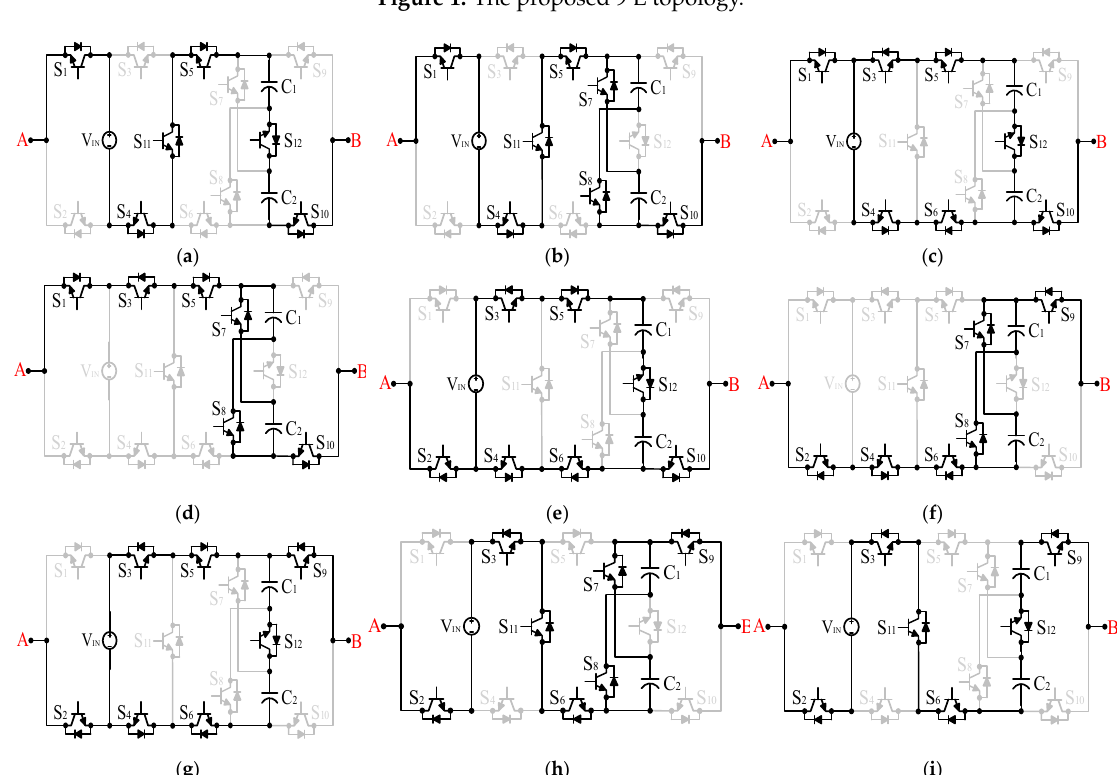
Figure 2. Switching states of the proposed inverter, ( a ) +2V IN , ( b ) +3V IN /2, ( c ) +V IN , ( d ) +V IN /2, ( e ) 0; ( f ) − V IN /2, ( g ) − V IN , ( h ) − 3V IN /2, ( i ) − 2V IN .